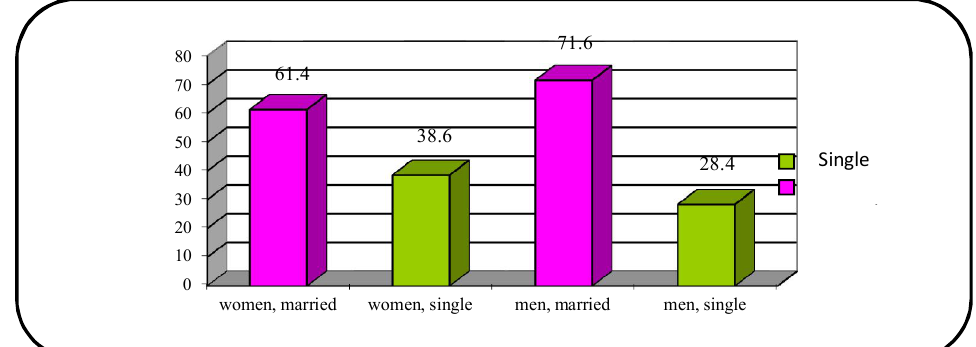
Fig. 2. The percentage of subjects in terms of